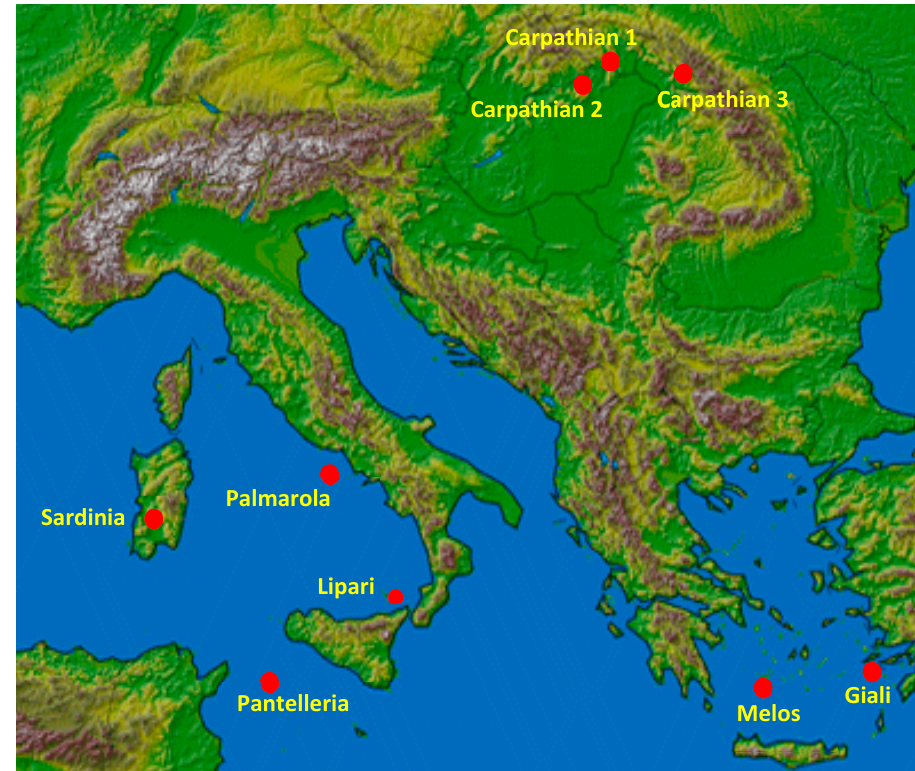
Figure 5. Map showing obsidian sources in Europe and the Mediterranean.